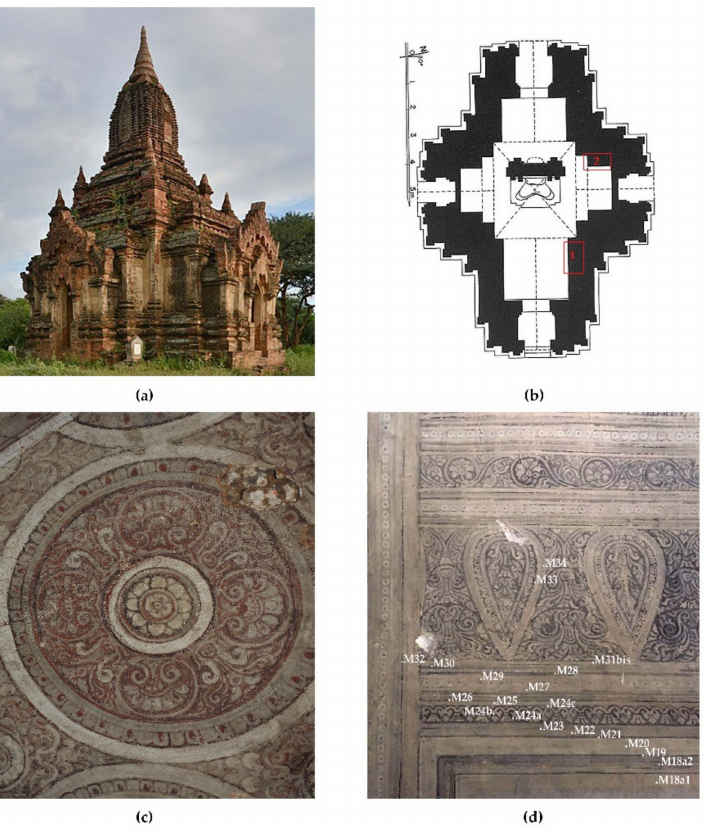
Figure 1. ( a ) Me-taw-ya temple (1205); ( b ) Me-taw-ya map by Pichard inventory with XRF investi- gated areas; ( c ) interior, detail of the circle pattern with lotus rosacea motif; ( d ) Eastern vestibule, north-east wall, detail of XRF investigated